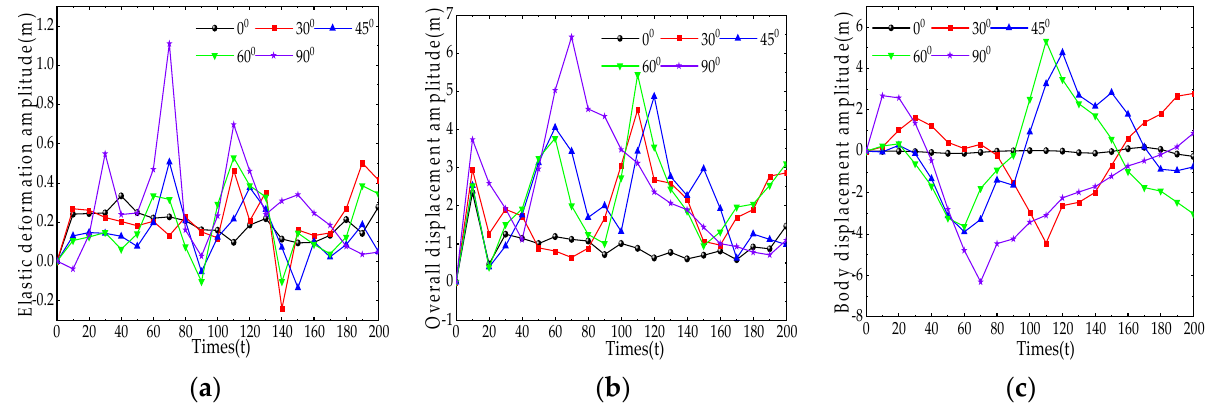
Figure 15. Magnitude of vertical displacement under different incident irregular waves. ( a ) Elastic deformation; ( b ) Total displacement; ( c ) Rigid displacement.